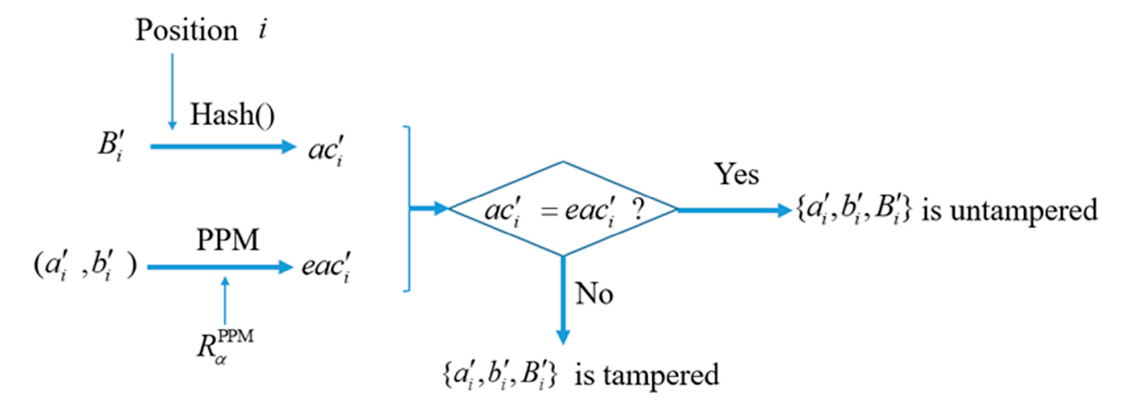
Figure 4. The authentication procedures of the proposed method.